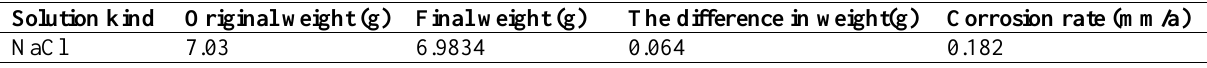
Weight loss results in the absence of inhibitor.